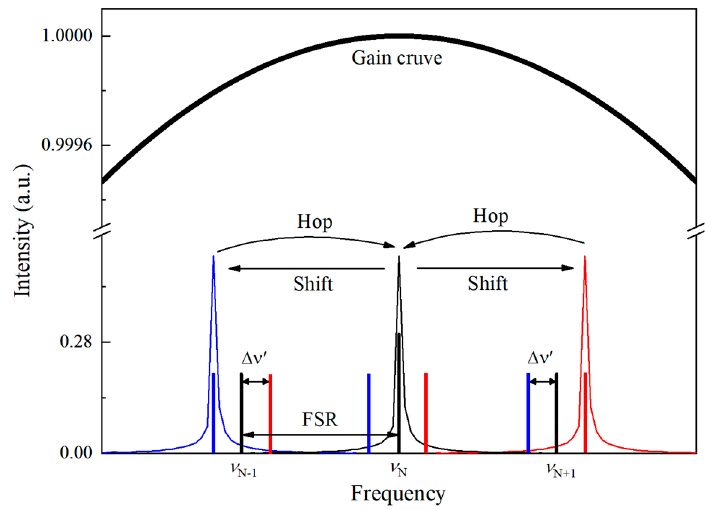
Figure 8. Principle of mode hop in a working SRO.